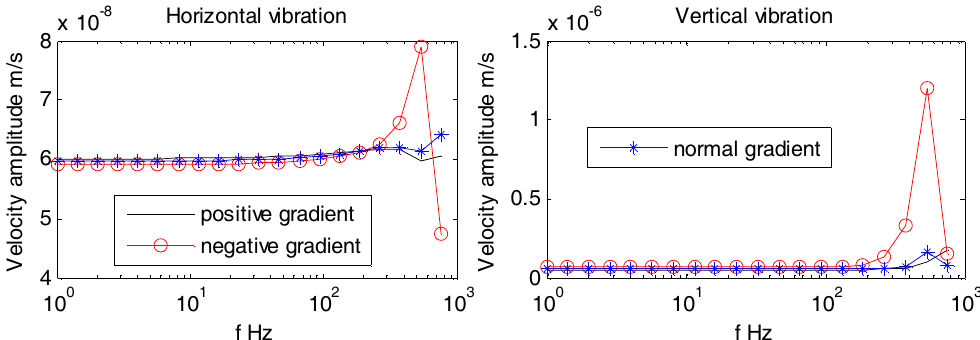
Figure 26. Vibration velocity amplitudes of the OBS with density gradients under incident angle of 60°.